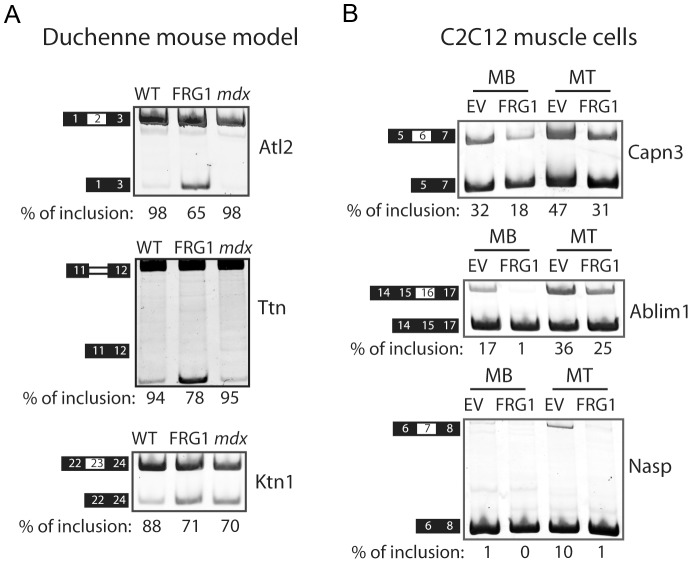
Alternative splicing changes are a primary consequence of FRG1 overexpression.(a) Examples of alternative exons (Atl2) or introns (Ttn) spliced normally in the mouse model of Duchenne muscular dystrophy, mdx mice, and example of an alternative exon similarly altered in FRG1 and mdx mice (Ktn1). (b) RT-PCR analysis of mRNA splicing variants from proliferating (MB) and differentiating (MT) C2C12 muscle cells over-expressing FRG1. Examples of alternative splicing changes present in both MB and MT (Capn3), only in MB (Ablim1), or only in MT (Nasp). Numbers are the percentage of exon inclusion. Black boxes illustrate constitutive exons, white boxes alternatively spliced exons and double lines represent the affected intron.